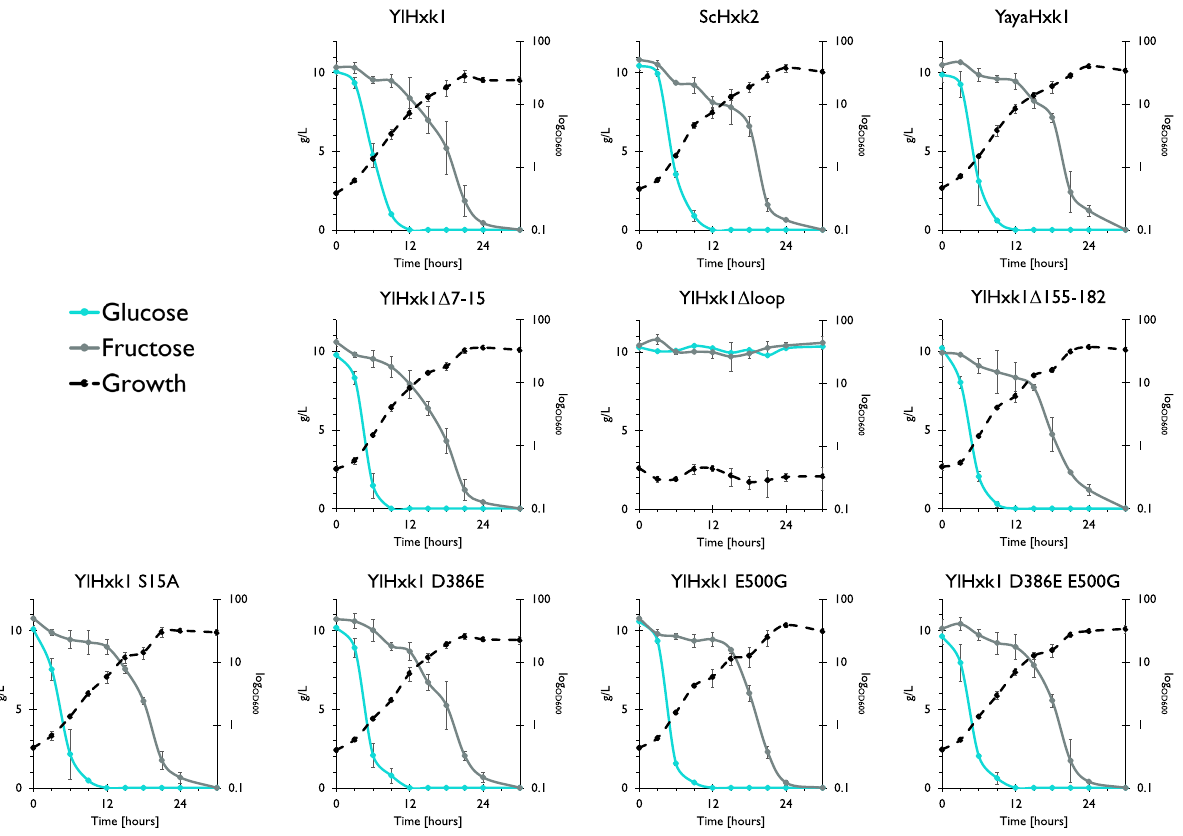
Figure 4. Growth and substrate utilization of Y. lipolytica strains expressing different hexokinase variantsin YNB minimal medium containing a mixture of glucose and